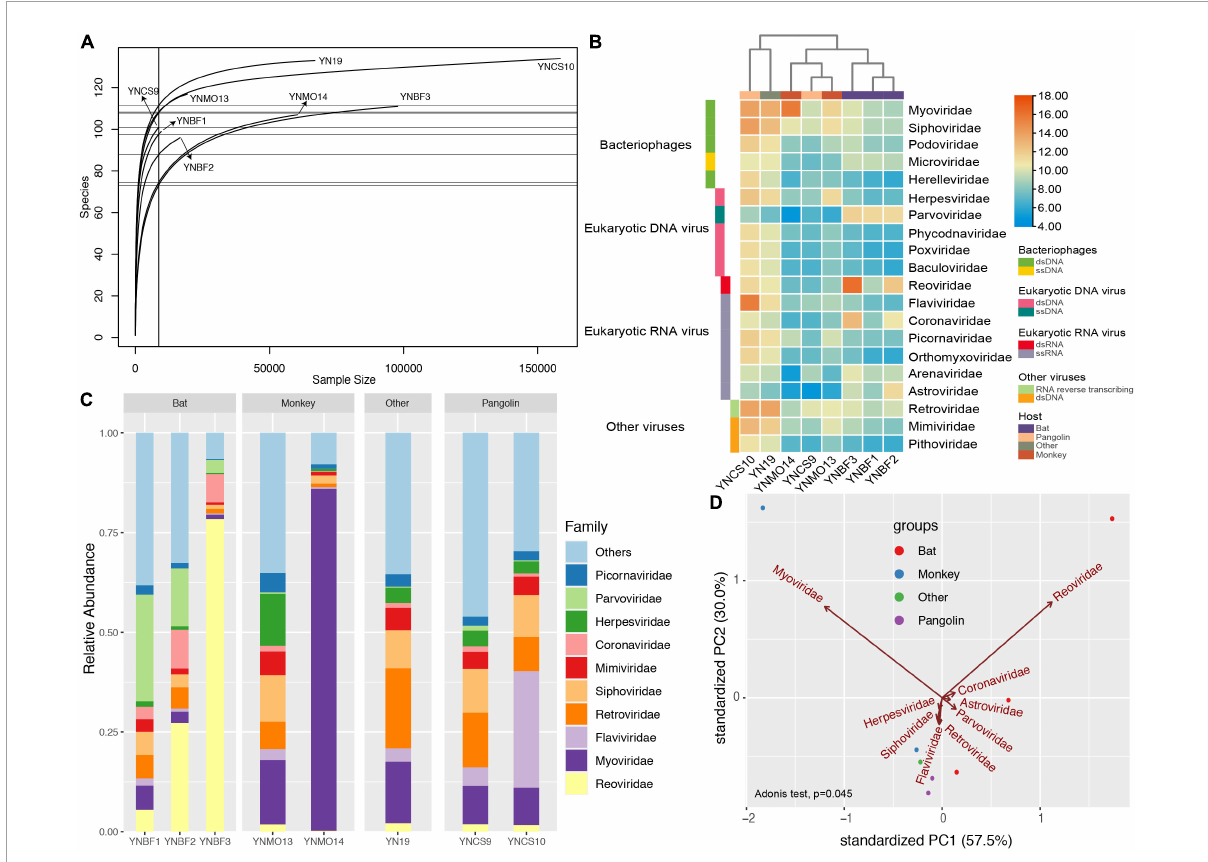
FIGURE2 Virome differences among the eight libraries based on read counts. (A) Rarefaction curves for each library, with the x -axis showing the sample size of each library and y -axis showing the viral species identified. (B) Heatmap showing the normalized abundance of the eight libraries at the family level. The red columns represent high abundance, and the blue columns represent low abundance. The taxonomical information was list in the right panel. (C) Virome composition at the family level. The top 10 virus families are shown. (D) Principal component analysis (PCA) showing multivariate variation (host information) and the major contributions of different factors (viral families) to PC1 and PC2. The first two PCA were used, and the groups are shown in different